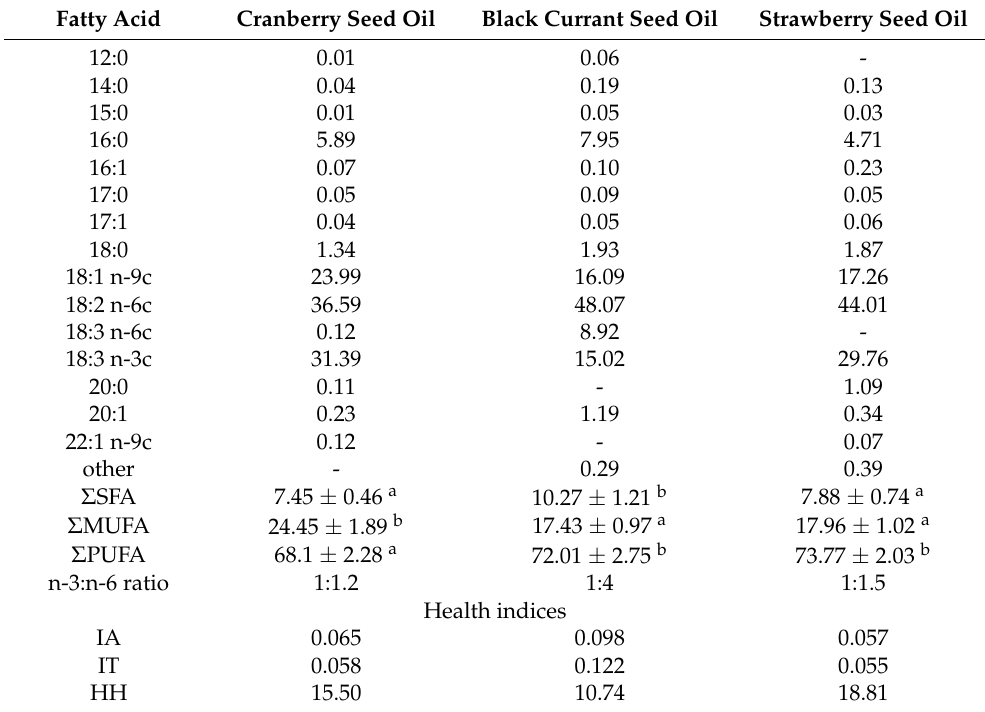
Table 1. Fatty acid composition [%] and health indices of cranberry, black currant and strawberry seed